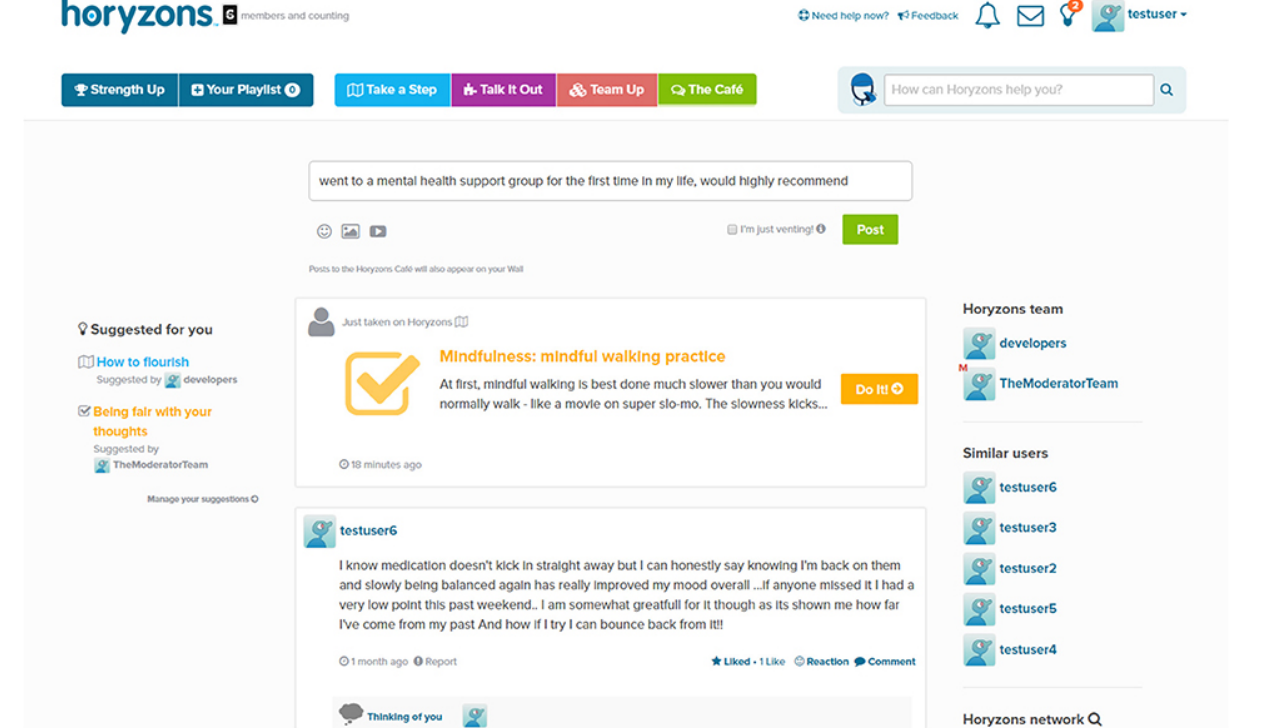
Figure 2. The Horyzons news